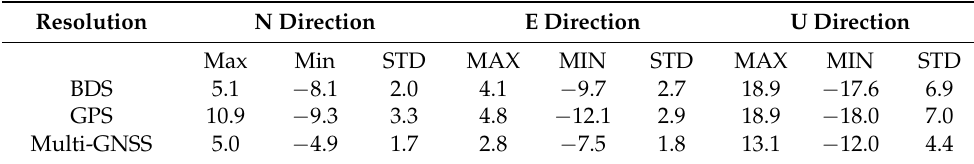
Table 8. The maximum, minimum errors and STD for different system combinations/mm. Table 9. Mean values of baseline resolutions (m).